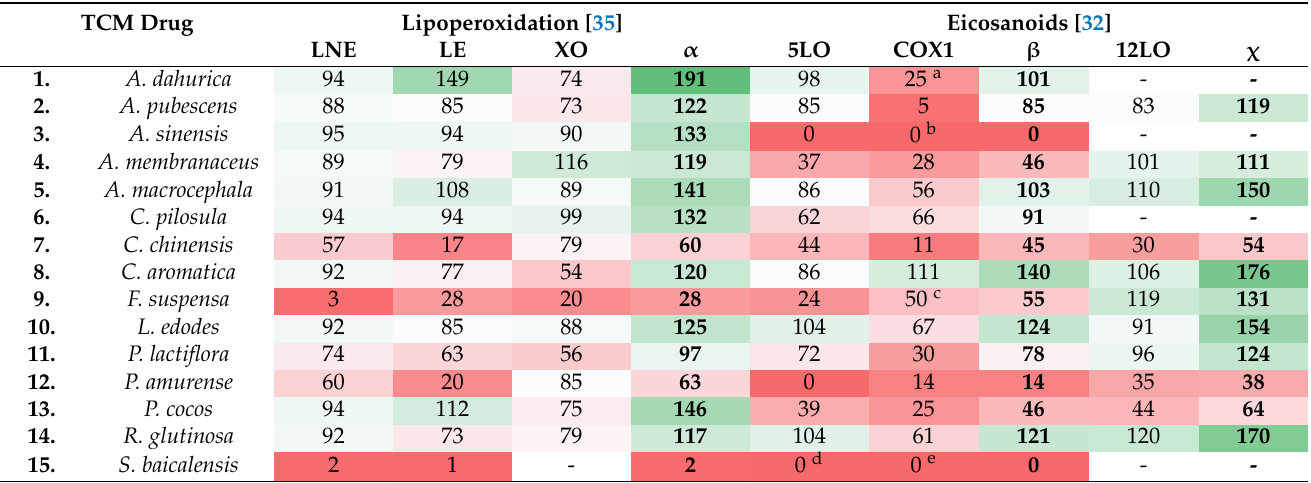
Table 2. Biochemical activities (percentage of inhibition of the measured endpoint) of the selected TCM herbal drugs and magnitude of the resulting vectors. Warm colours denote high inhibitory activity whilst cold colours the